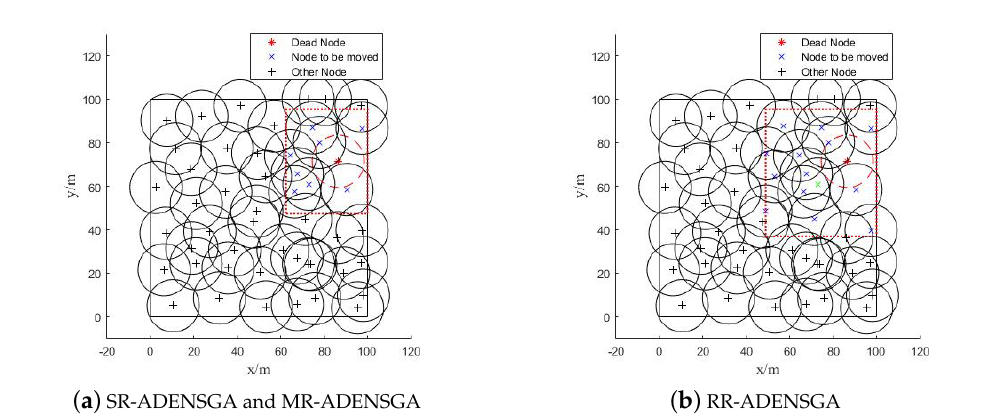
Figure 8. Optimization Region and Position of Nodes to be Moved in Situation